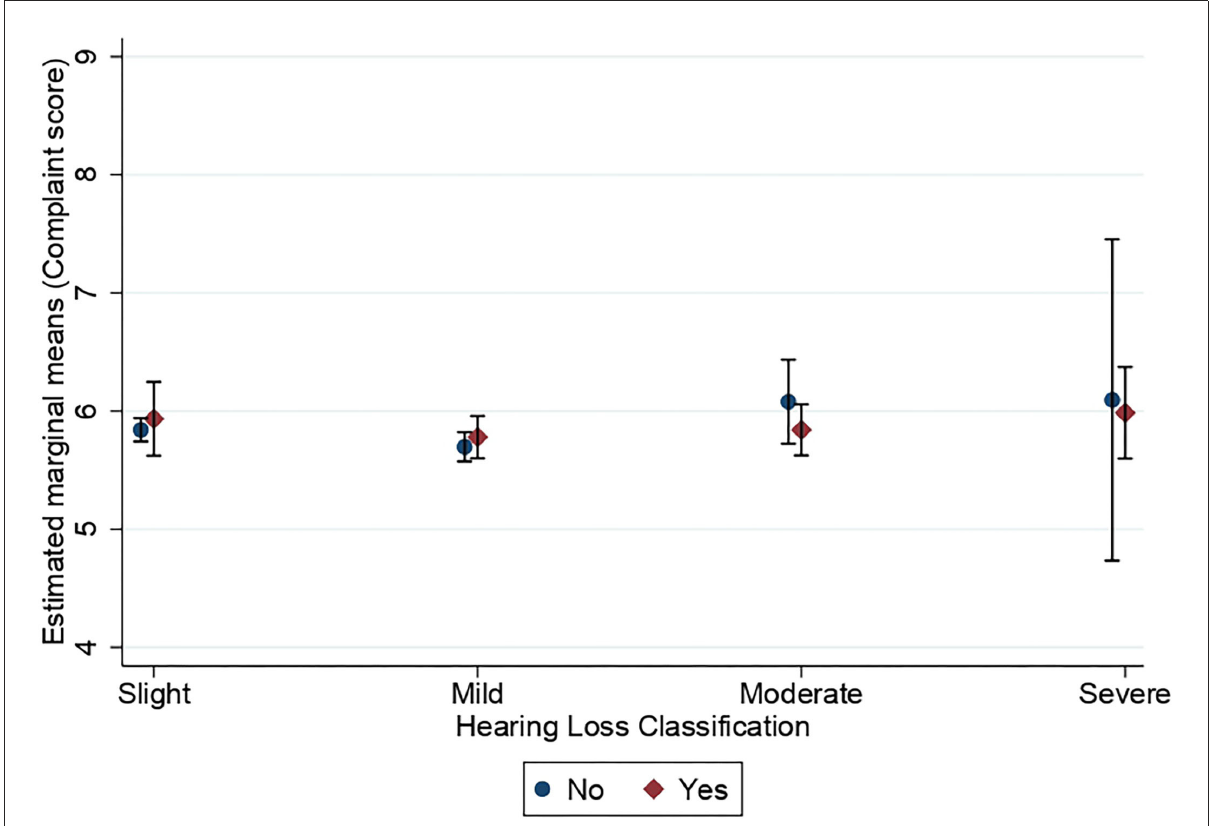
FIGURE4 Estimated marginal means of subjective short-term memory complaints as a function of hearing status and use of hearing aids. Estimates are averaged over the levels of age at the means of the covariates sex, education, stroke, diabetes, smoking, and hospital admission for a head injury. The error bars indicate 95% confidence